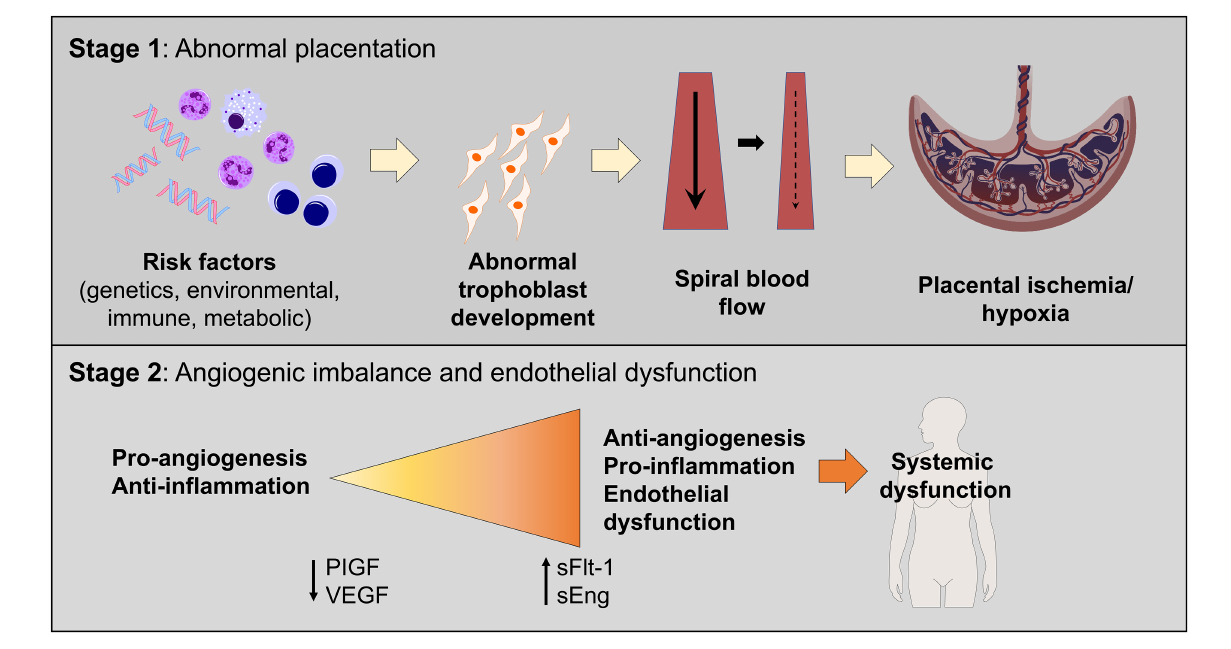
FIGURE 1 Two-staged model of preeclampsia pathogenesis. Stage 1 consists of the preclinical stage and is characterized by abnormal placentation, which leads to the release of soluble factors in maternal circulation, leading to systemic endothelial dysfunction and hypertension (Stage 2).